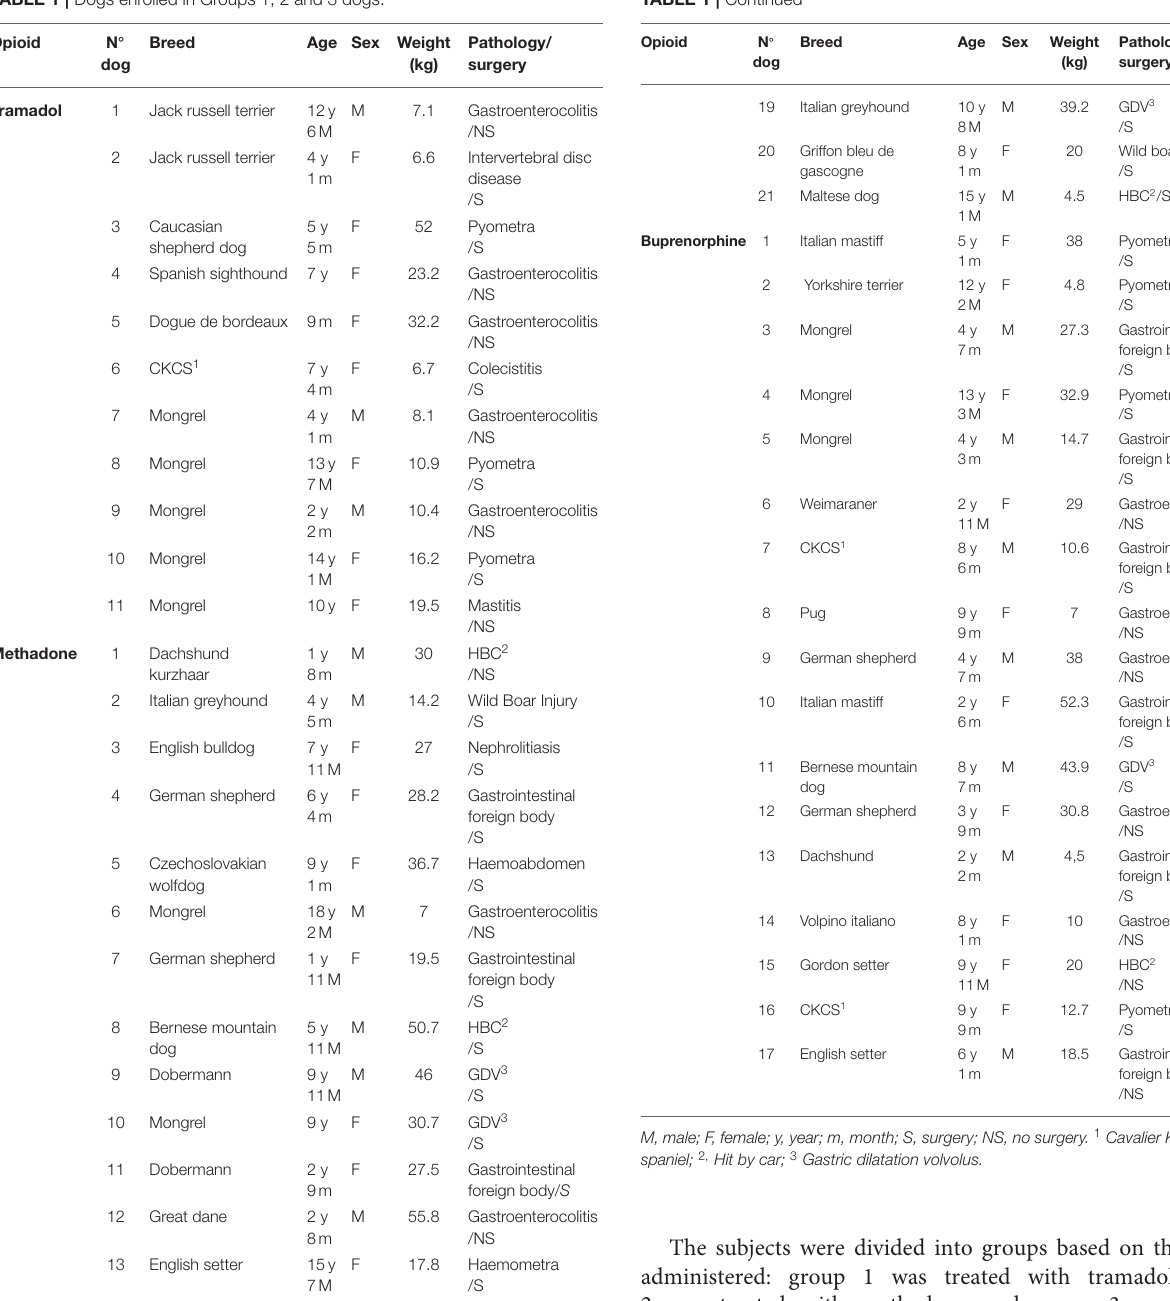
Pathology/ (kg) surgery